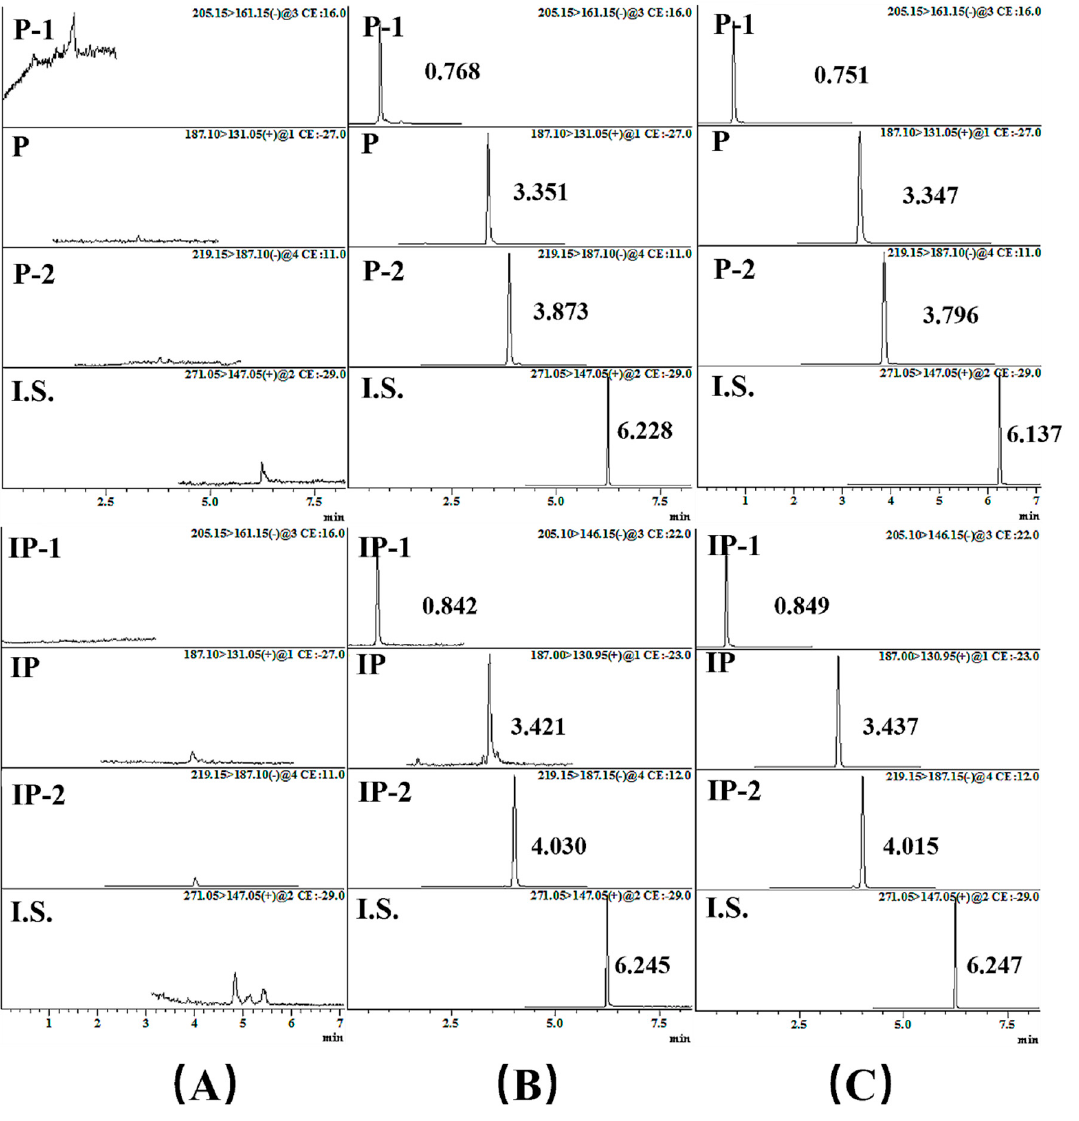
Figure 3. The typical MRM chromatograms with di ff erent disposal manners; ( A ) blank bacterial suspension; ( B ) blank bacterial suspension spiked with the six analytes and I.S. (LQC); ( C ) the chromatograms of the six components and I.S. in an active bacterial suspension, which were obtained at 12 h.